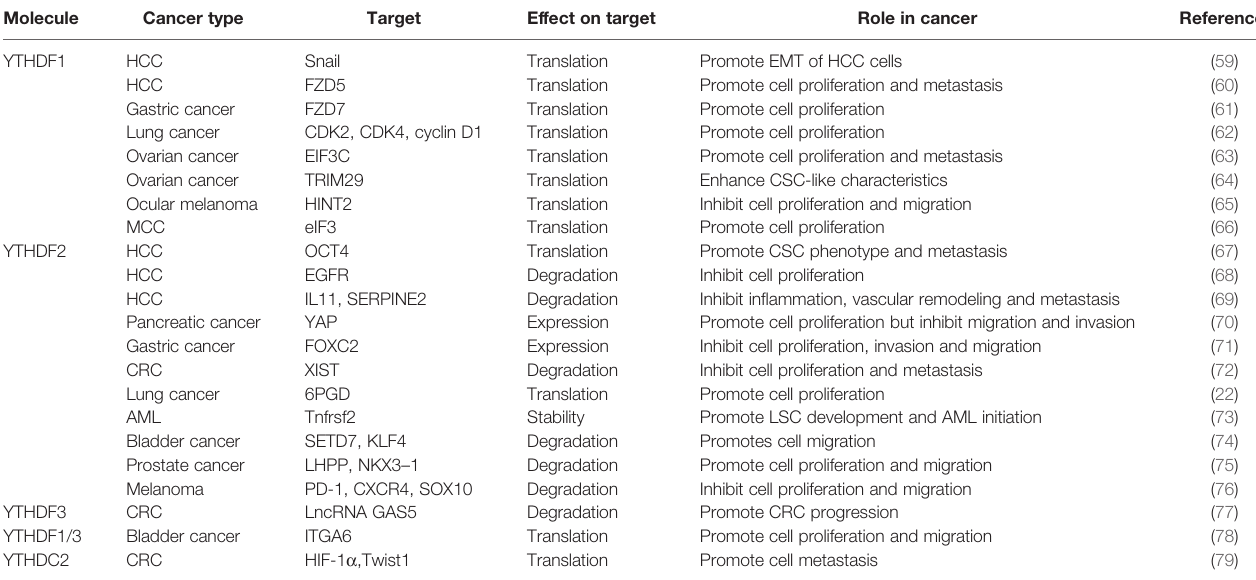
TABLE 1 | Multiple functions exerted by YTH family proteins in various cancers. Molecule Cancer